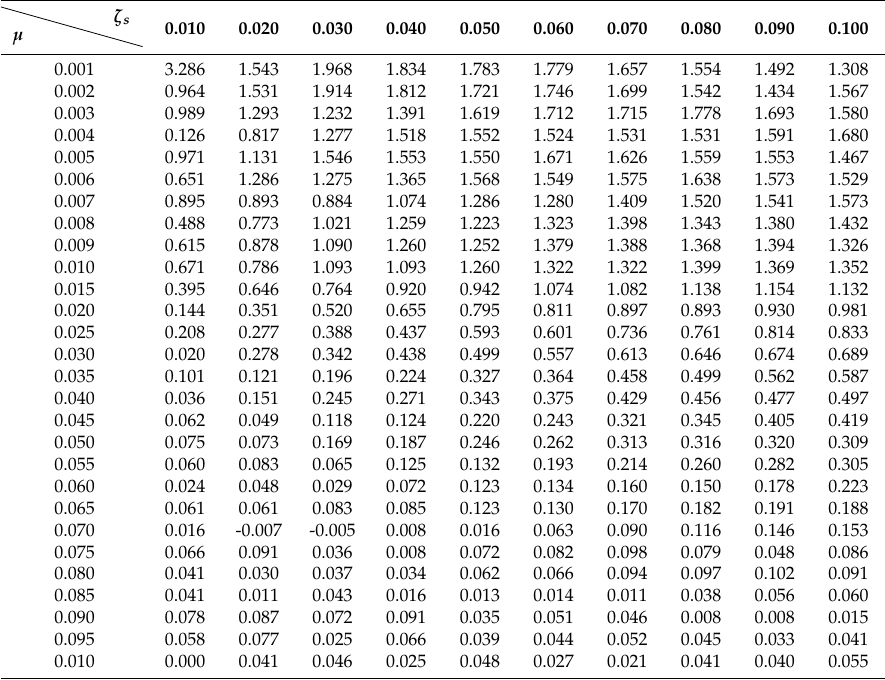
Table 3. Reduction ratio compared to the Ioi Toshihiro method/%.